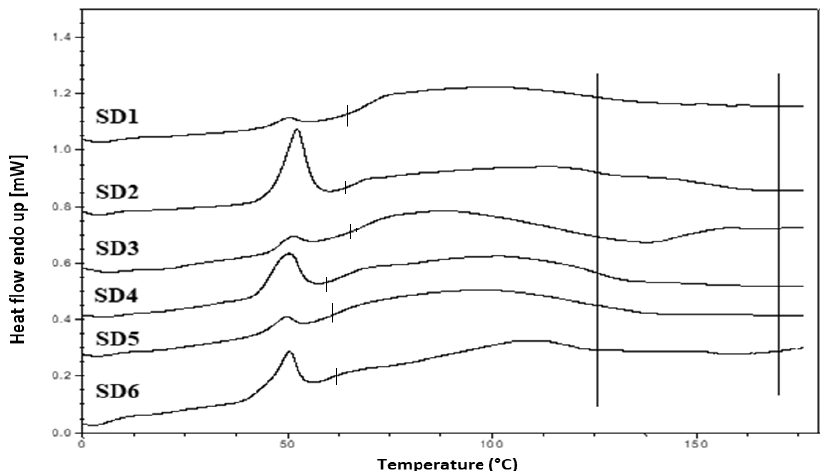
Figure 14. XRPD diffractograms of SD formulations and XRPD diffractograms of the SD formulation used to investigate the effect of cooling after 5 months of a stability study under accelerated conditions of 40 °C and 75% RH. P407 was still present in its crystalline form in all formulations (AC = Air cooled, NT = Normal room temperature and Liq N 2 = Liquid Nitrogen).